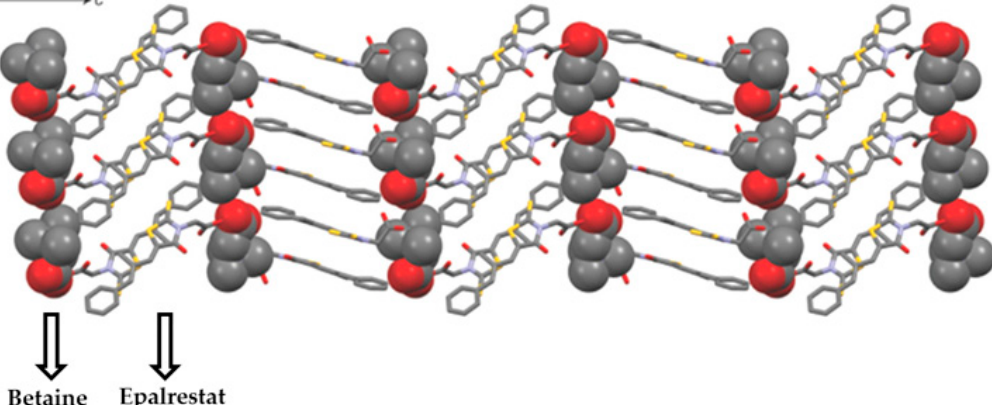
Figure 5. Layered cocrystal structure of epalrestat and betaine. Reprinted (adapted) with permission from [21]. Copyright (2018) American Chemical Society.